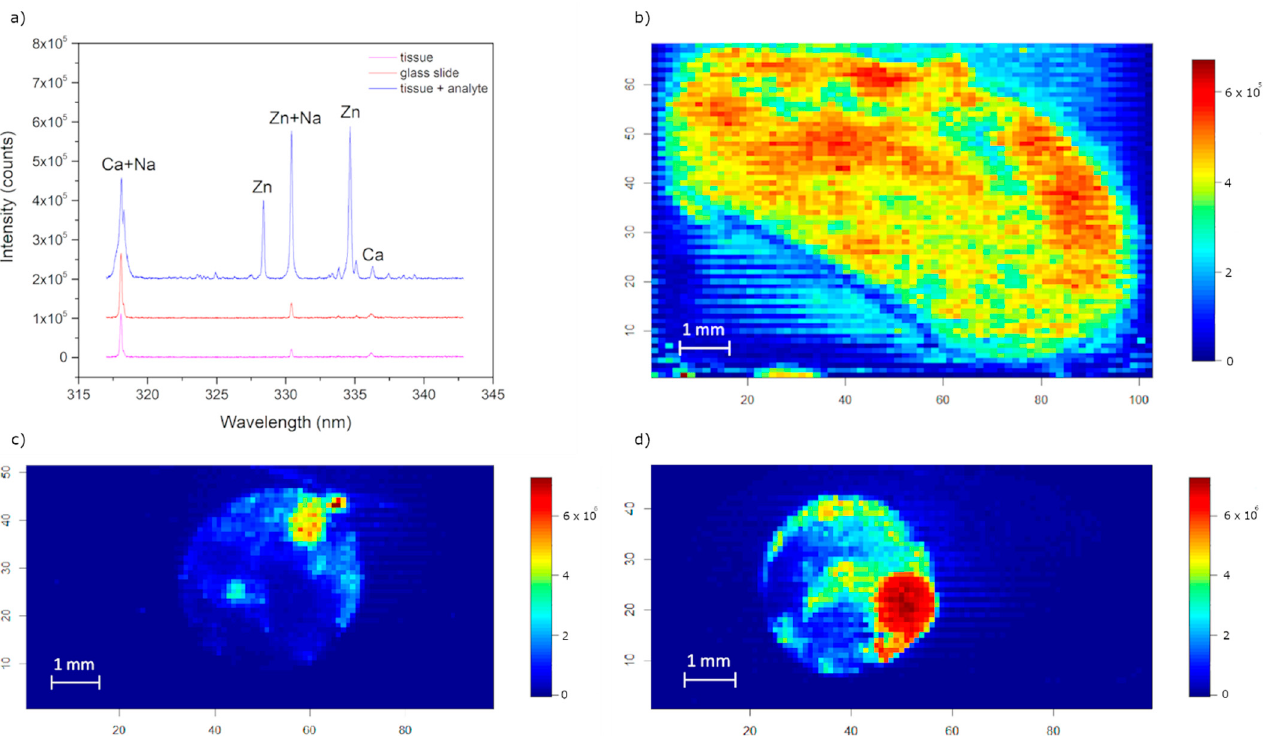
Figure 1. ( a ) Typical laser-induced breakdown spectroscopy (LIBS) spectrum of three different regions in a sample: kidney tissue—magenta color, glass slide with paraffin—red color, zinc drop on the mouse kidney—blue color. Spectra were rearranged vertically for a better clarity. False color map of: ( b ) calcium line Ca I 336.19 nm in kidney tissue; ( c ) zinc drop on soft tissue (Zn I 334.5 nm); ( d ) zinc drop on soft tissue with previously optimized parameters (Zn I 334.5 nm). Table 3. Table of element lines and their attributes ( λ —wavelength, A ki —Einstein coefficient, E i — energy of lower level, E k —energy of upper